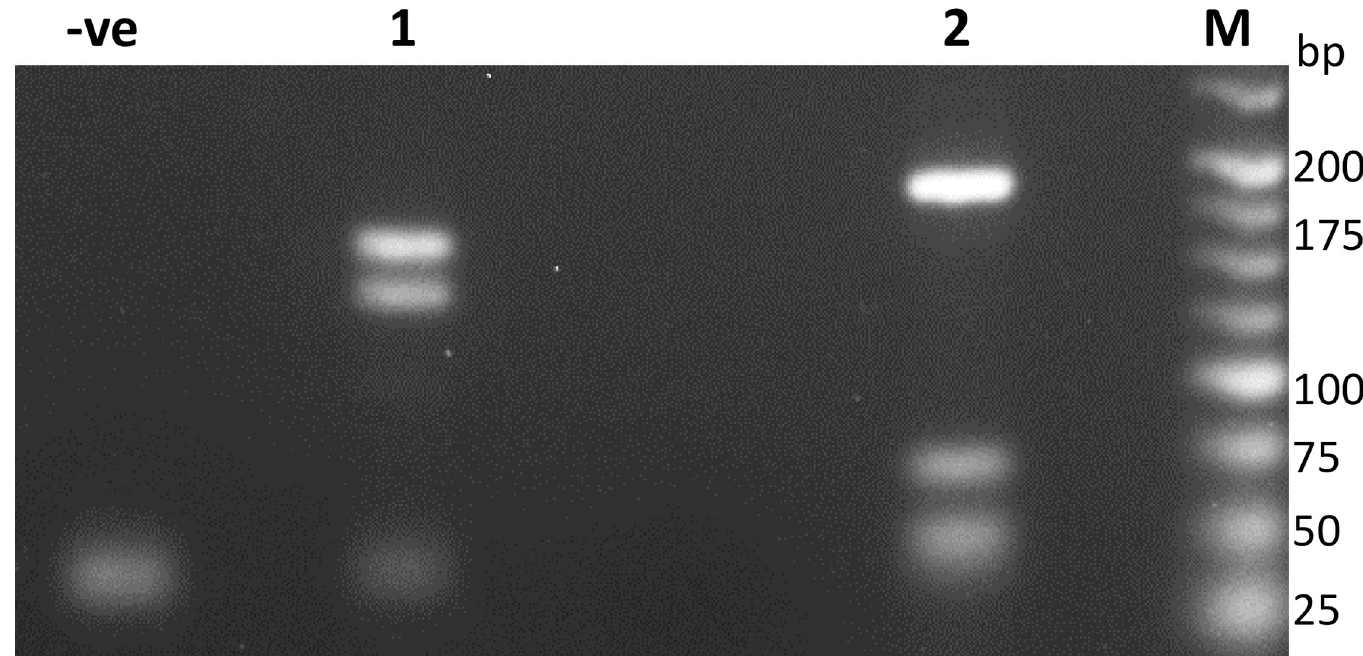
Fig 6. PCR-RFLP using ITS1/ Hae III reveals the presence of canine leishmaniasis compatible with Viannia infection (see Discussion) (Lane 1, broach sample) in Puerto Iguazu´, as well as CVL due to L . infantum (Lane 2, lymph node aspirate); -ve, negative control; M, size markers.